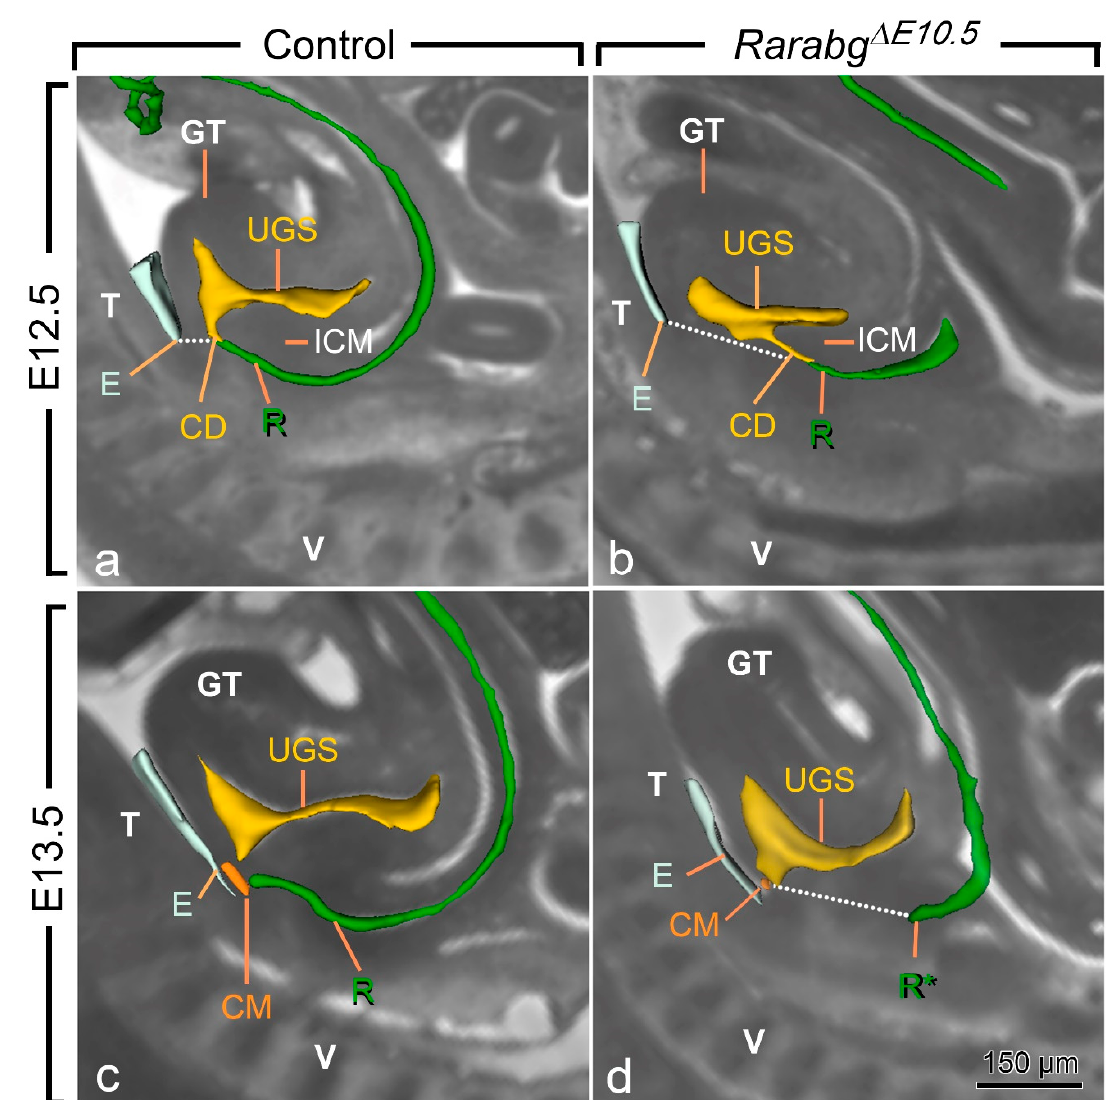
Figure 4. Left lateral views of the urogenital sinus (UGS) and gut in control ( a , c ) and Rarabg ∆ E10.5 mutant ( b , d ) littermates at E12.5 and E13.5 as indicated, with projections on sagittal HREM sections. Note that the layer of mesoderm separating the cloacal duct (CD) and/or the rectum from the base of the genital tubercle is much thicker in mutant embryos than in the controls (dotted lines), whereas the intra-cloacal mesenchyme (ICM), sandwiched between the UGS and rectum, is much less developed in the mutants than in the controls. CM, site of disintegration of the cloacal membrane; E, ectodermal groove between the genital tubercle and the tail; GT, genital tubercle; R and R*, lumen of the rectum and blind ending of the mutant rectum; T, tail; UGS, lumen of the urogenital sinus; V, vertebrae. Scale bar (in d ): 150 µm ( a – d ).